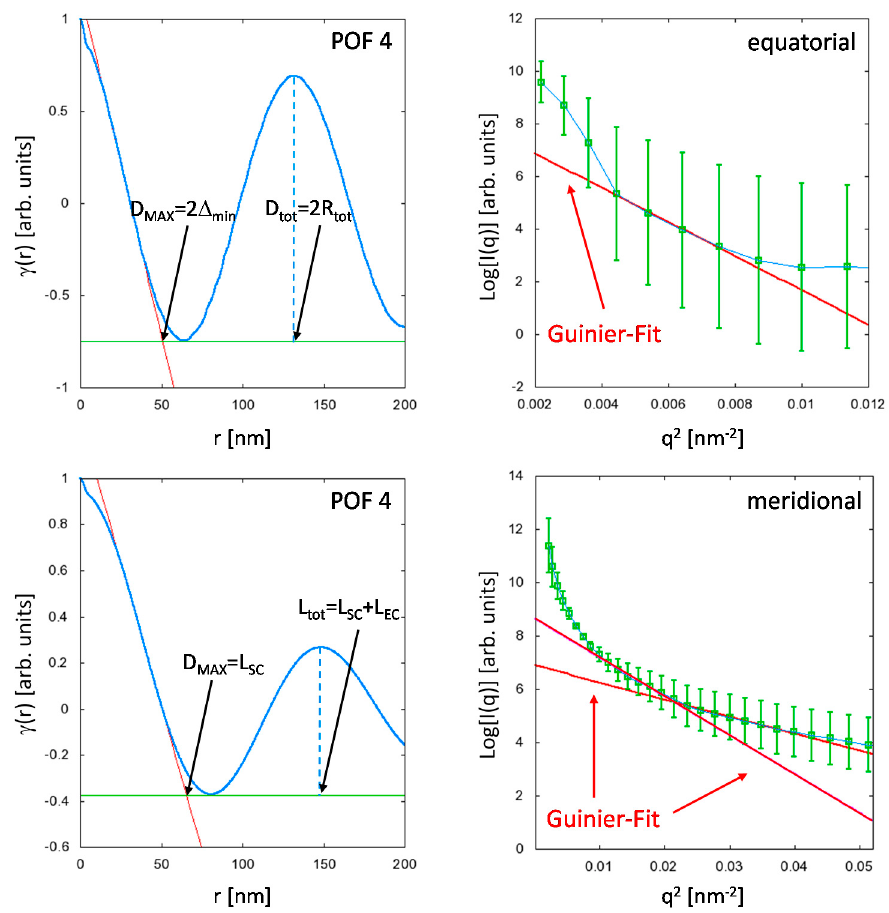
Figure 6. Analysis of the equatorial ( Top row ), and meridional ( Bottom row ) scattering contributions using the Guinier fit and the Patterson function exemplarily shown for the sample POF 4. Note that r corresponds to a distance, i.e., for the analysis of the equatorial SAXS intensities, D MAX = 2 ∆ min , and for the meridional SAXS, D MAX = L SC . The correlation peaks in the meridional and equatorial Patterson functions correspond to periodically occurring density variations along the fiber axis and the fiber cross-section, respectively.